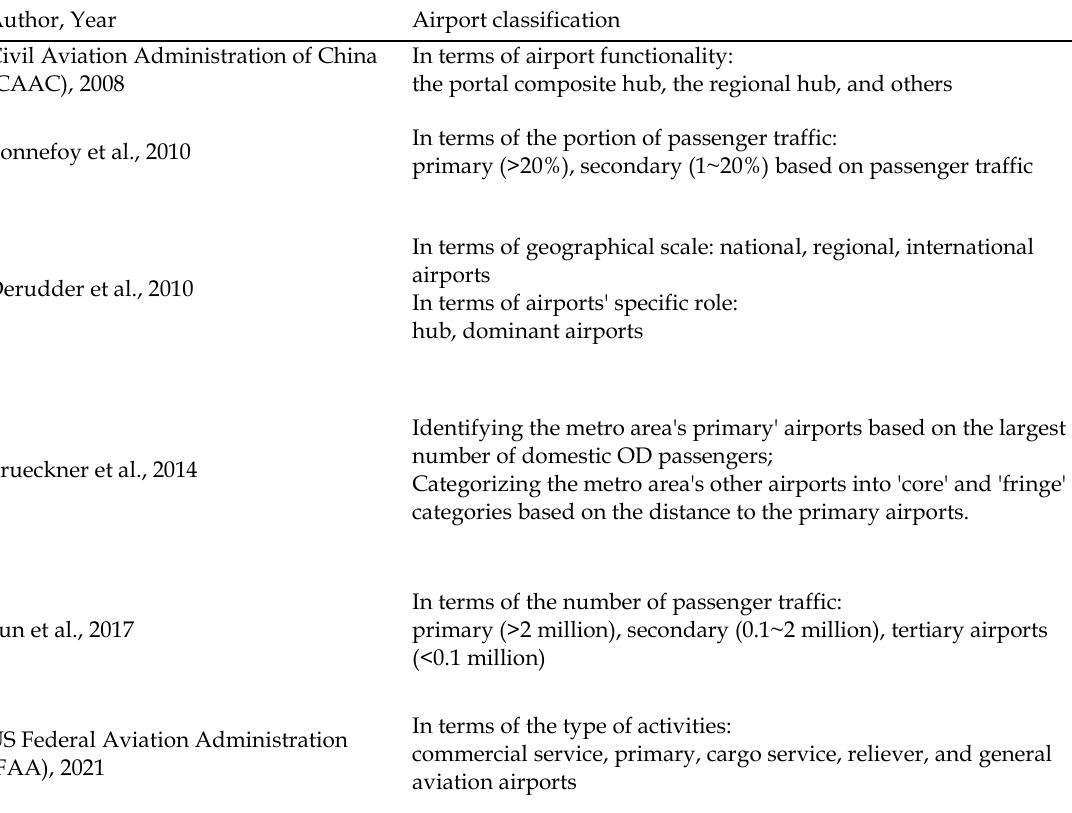
Summary of airport classifications in different reports and